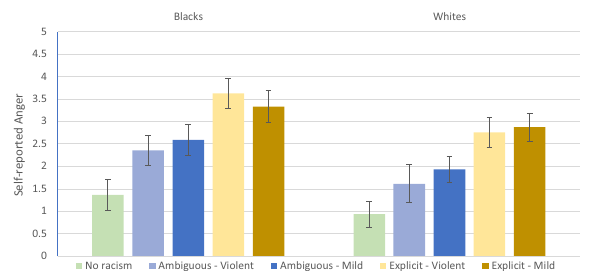
Fig. 5 Mean ratings ( + se ) of self-reported anger at the end of the videos as a function of racist cues presented in each of the fi ve video conditions. The presence of racist cues elicited greater anger, particularly in response to explicit (relative to ambiguous) racism, irrespective of whether the events were mild or violent.